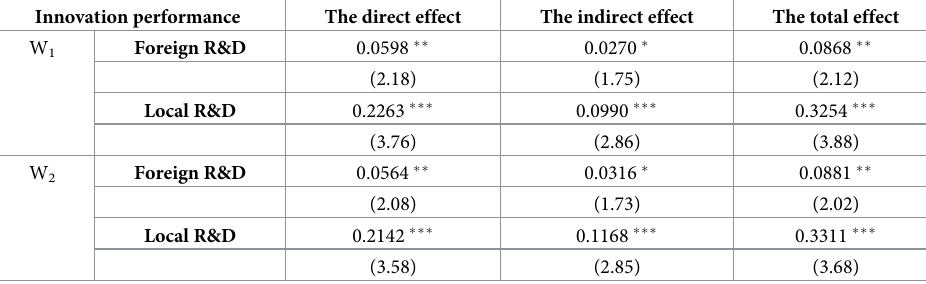
Table 8. Direct effect, indirect effect, and total effect of SAR model